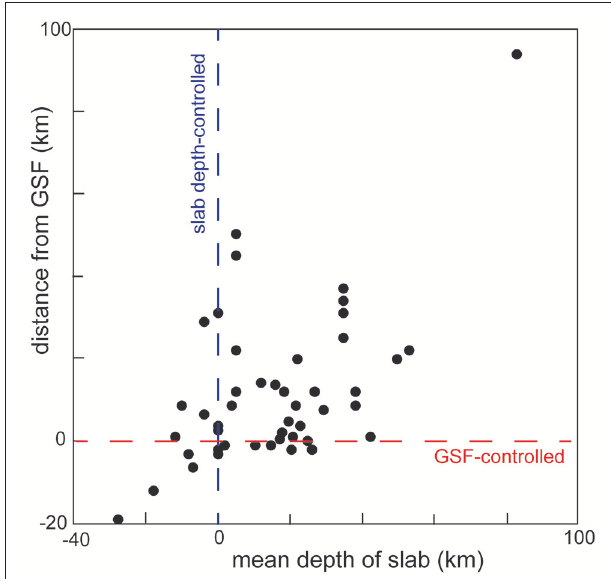
FIGURE 3 | Distribution of volcanoes as a function of the mean depth of the slab (considering a reference of 130km, see Figure 2C ) and of the GSF. See text for